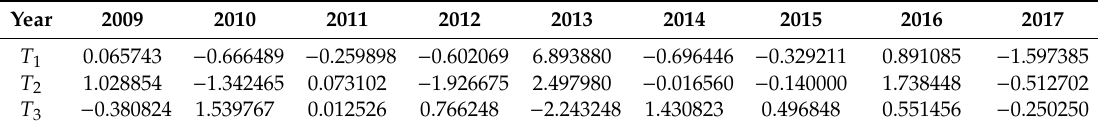
Table 4. Calculated decoupling index.